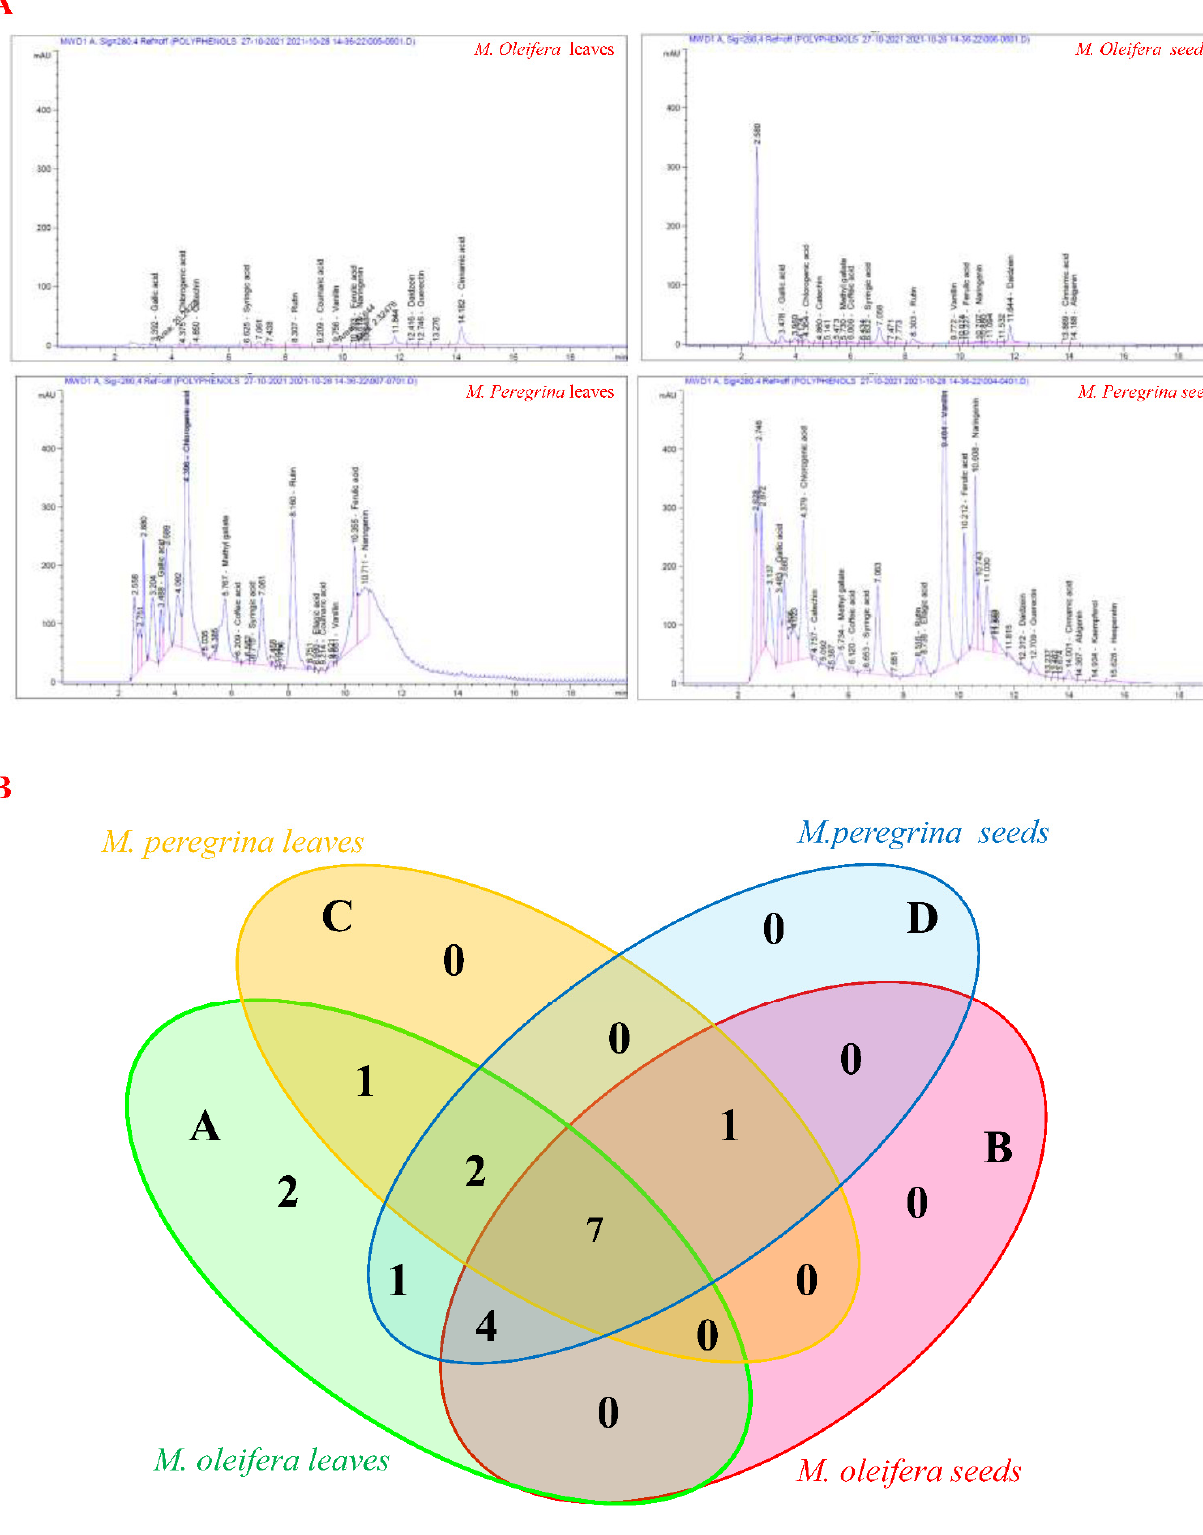
Figure 4. HPLC profile analyses polyphenols from the leaves and seeds of M. oleifera and M. peregrina . ( A ) HPLC peak of the extracts, ( B ) four-way Venn diagram to show the number of unique and common compounds in the extracts from M. oleifera leaves (a), M. oleifera seeds (b), M. peregrina leaves(c), and M. peregrina seeds (d).